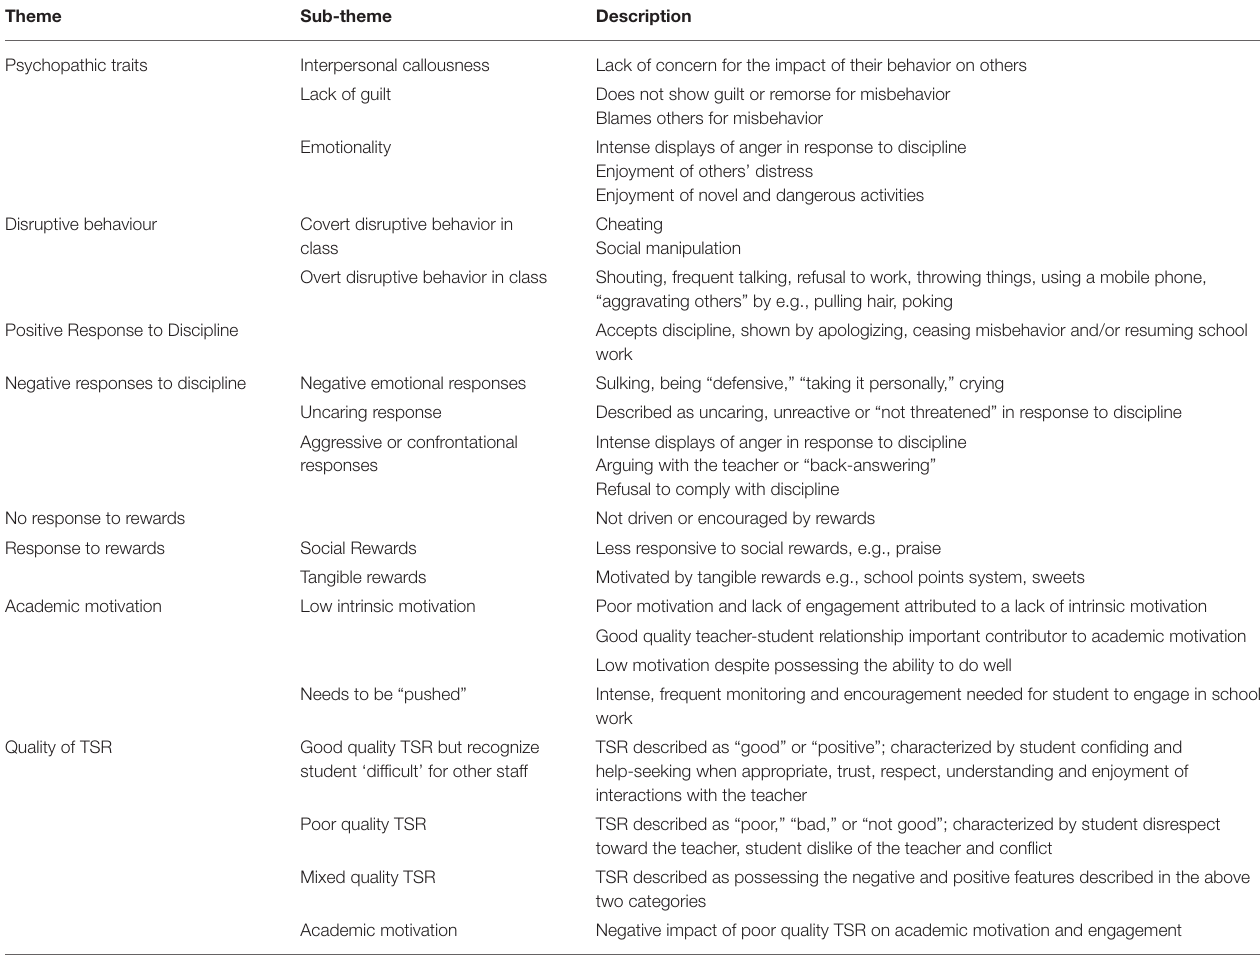
TABLE 5 | Qualitative findings for CU traits, disruptive behavior, response to rewards and discipline, academic motivation, and teacher-student relationship quality in high CU